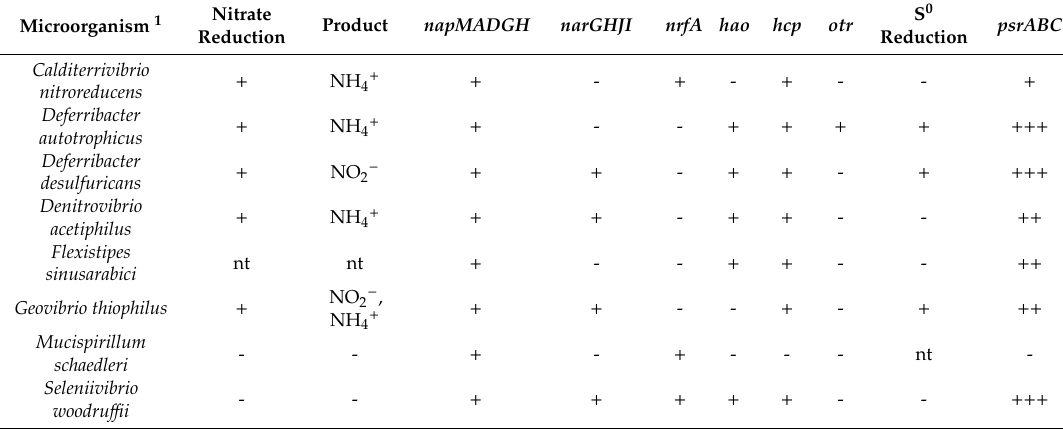
Table 2. Dissimilatory nitrate and elemental sulfur reduction and related genes in genome-sequenced Deferribacteres .